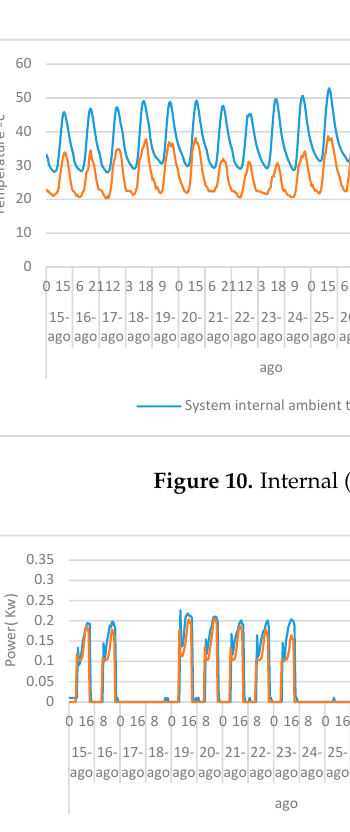
Figure 11. Module 1b. Behavior of the System and model cooling climatic system.